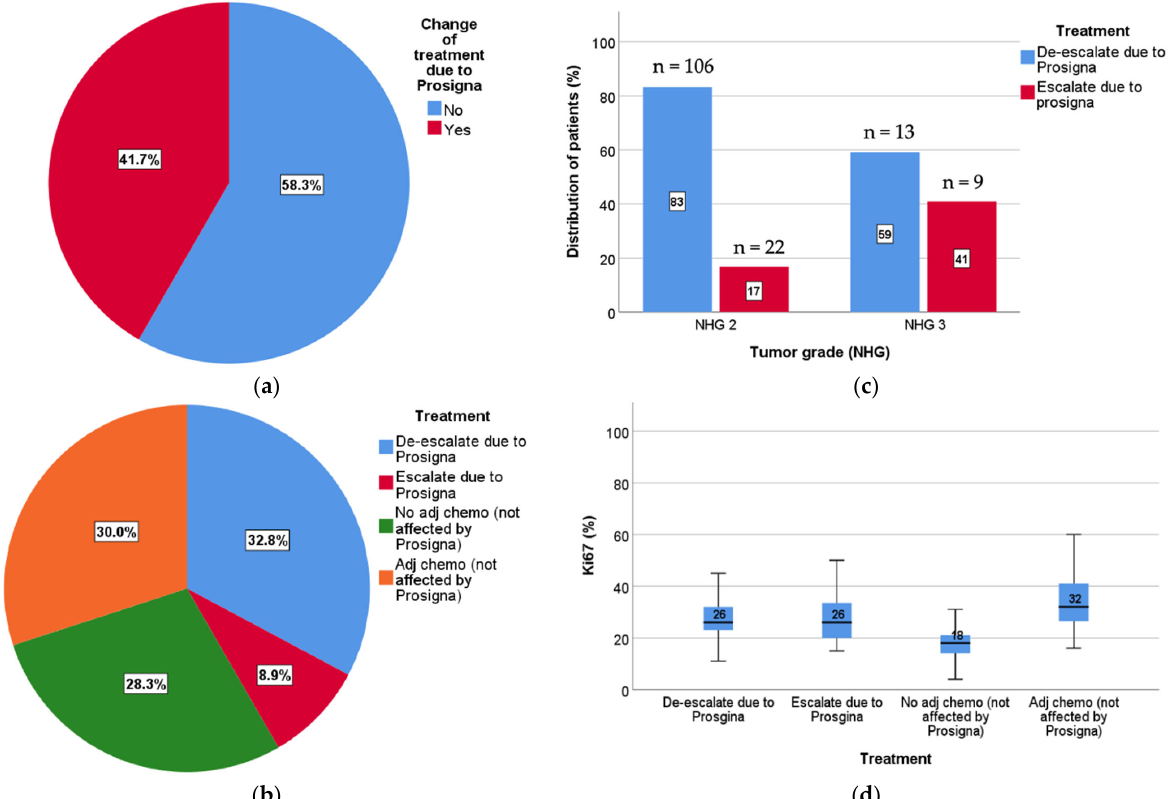
Figure 2. Impact on treatment decision after Prosigna test. ( a ) Percentage of patients in which treat ‐ ment decision was changed based on ROR results (blue) or confirmed (red); ( b ) the fraction of pa ‐ tients who could avoid ACh (blue) or needed to receive ACh (red) based on ROR results. Patients not affected by ROR testing either were treated (orange) or not treated (green) with ACh based on routine tumor characteristics and treatment guidelines; ( c ) change of treatment due to Prosigna in NHG groups. Of all patients impacted by testing, 83% of grade 2 tumors were de ‐ escalated (blue) and 17% escalated (red). Among grade 3 tumors, 59% were de ‐ escalated (blue) and 41% escalated (red); ( d ) change of treatment due to Prosigna vs. Ki67. No difference in Ki67 expression was seen between the patients with a treatment change (de ‐ escalated versus escalated) ( p = 0.954). Patients not affected by test results showed different Ki67 expression in the ACh versus non-ACh groups ( p =